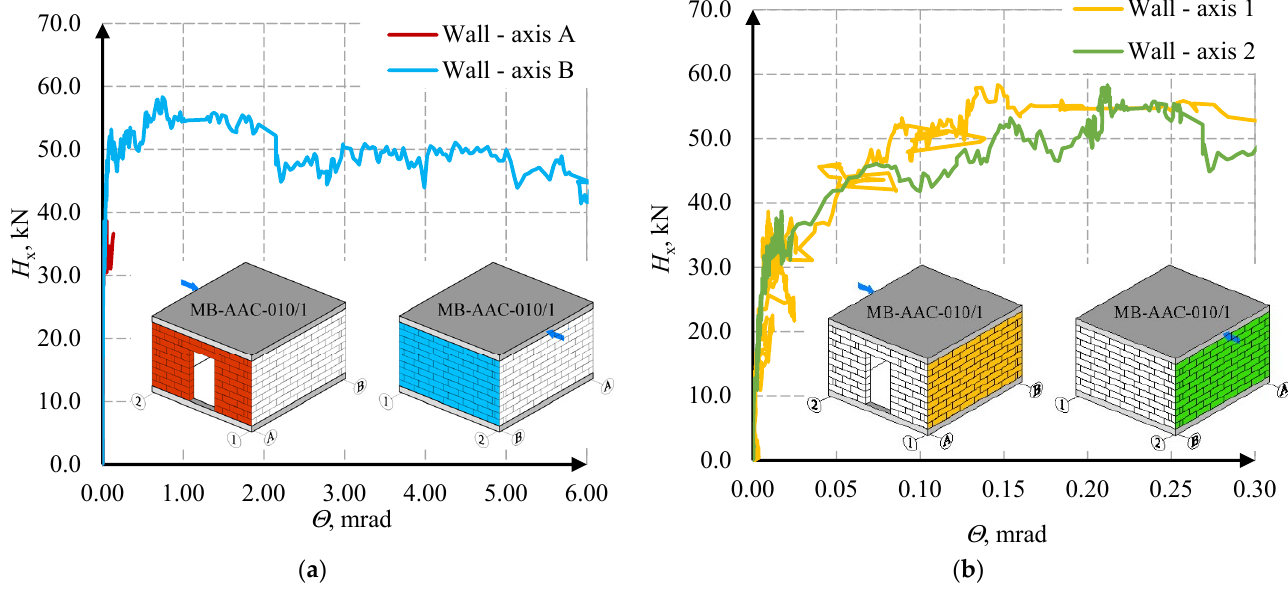
Figure 15. Relationship between horizontal force and strain deformation angle for MW-AAC-010/1 model; ( a ) results for A and B wall ( b ) results for 1 and 2 wall.